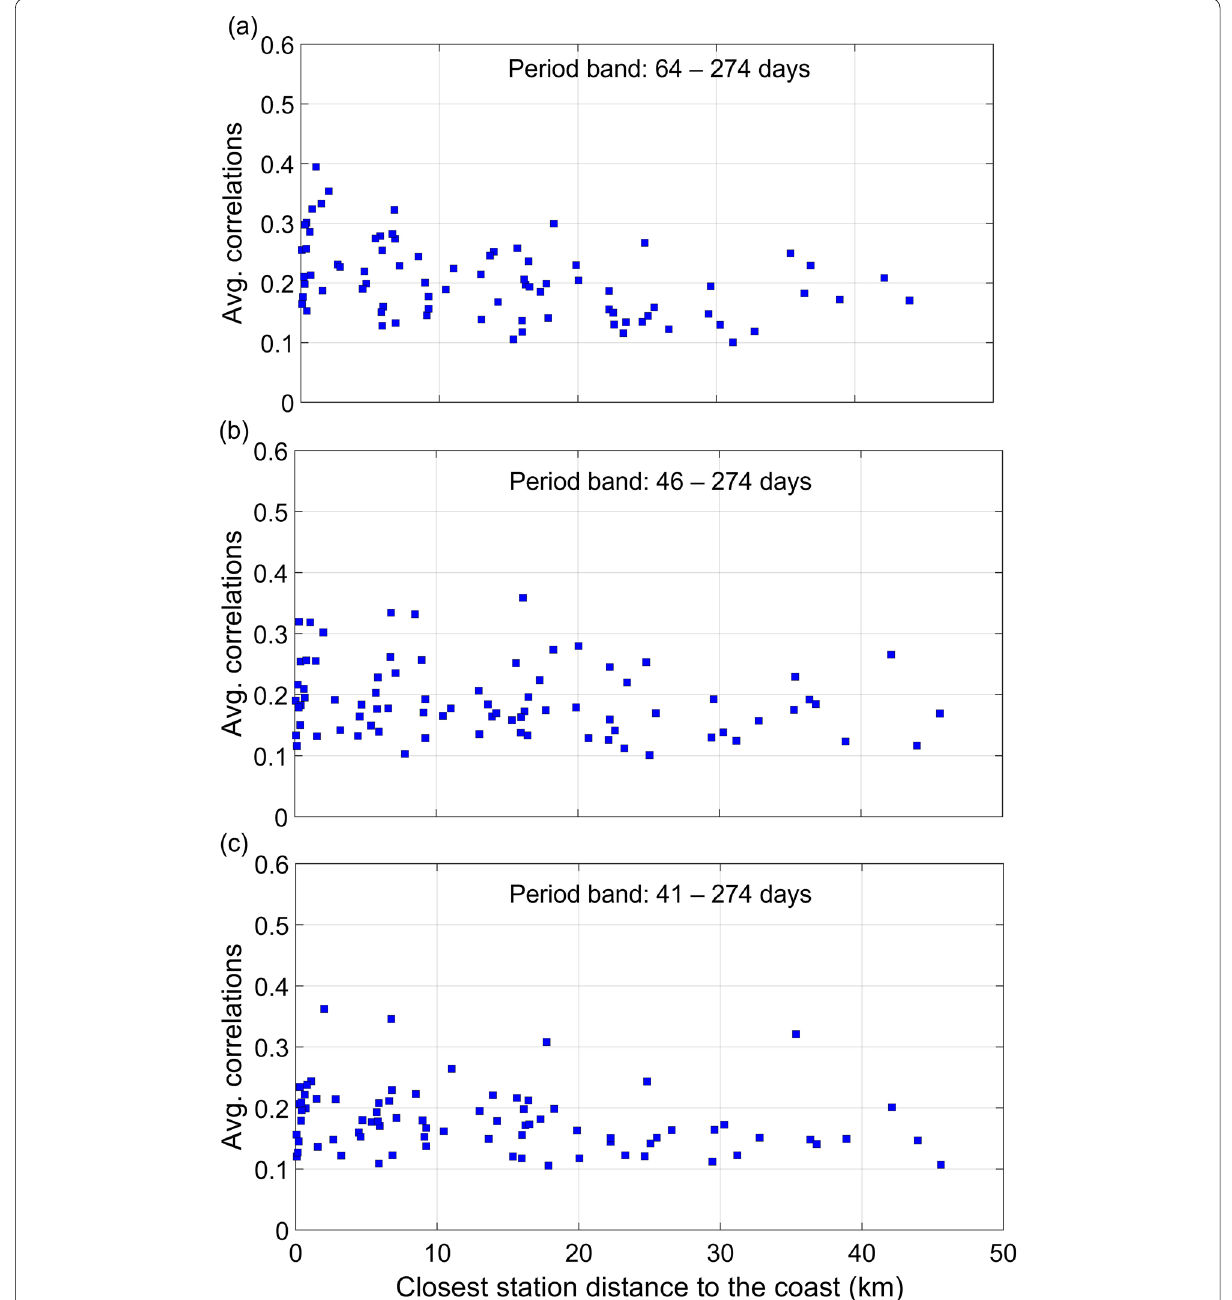
Fig. 5 Scatterplots between the average absolute correlation between sea level and seismic velocity change and the distance from the coast for period bands of a 64–274, b 46–274, and c 41–274